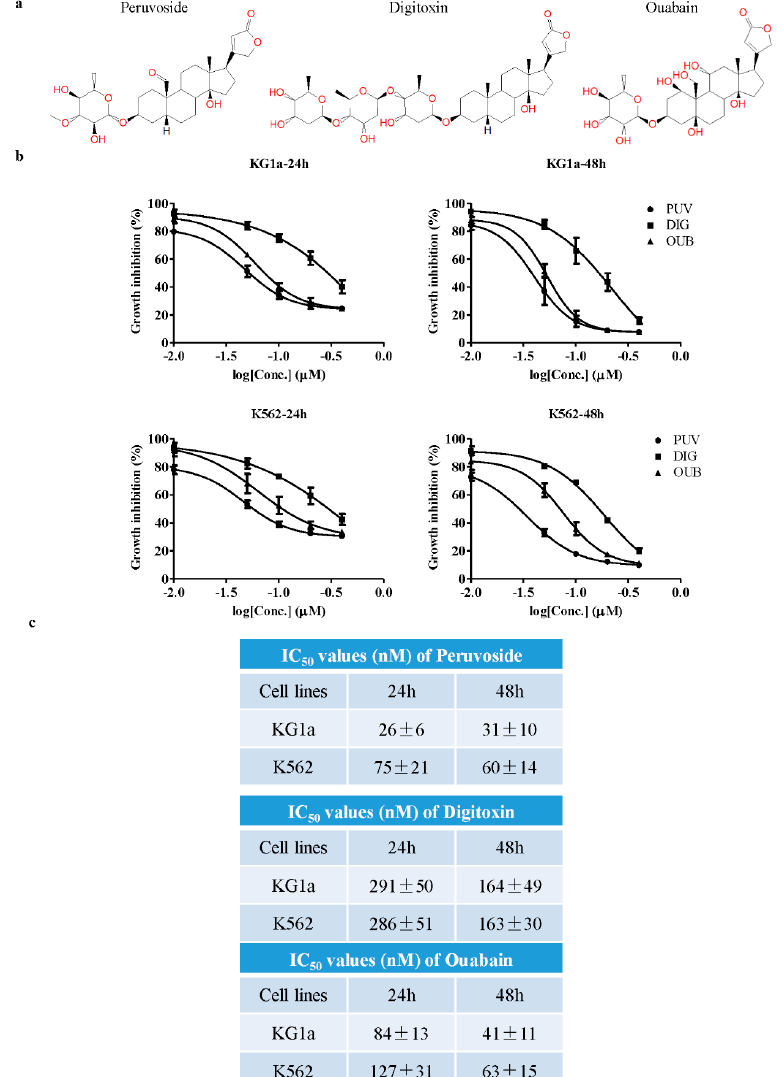
Figure 1. Peruvoside is more effective in suppressing the growth of human leukemia cells. ( a ) Structure of Peruvoside, Digitoxin and Ouabain; ( b ) Dose response of three different cardiac glycosides (CGs) in human leukemia cell line KG1a and K562 at two different time points. MTT assay was used to assess cell viability 24 and 48 h after treatment ( n = 3); ( c ) IC 50 values of different CGs 24 and 48 h after treatment ( n = 3).